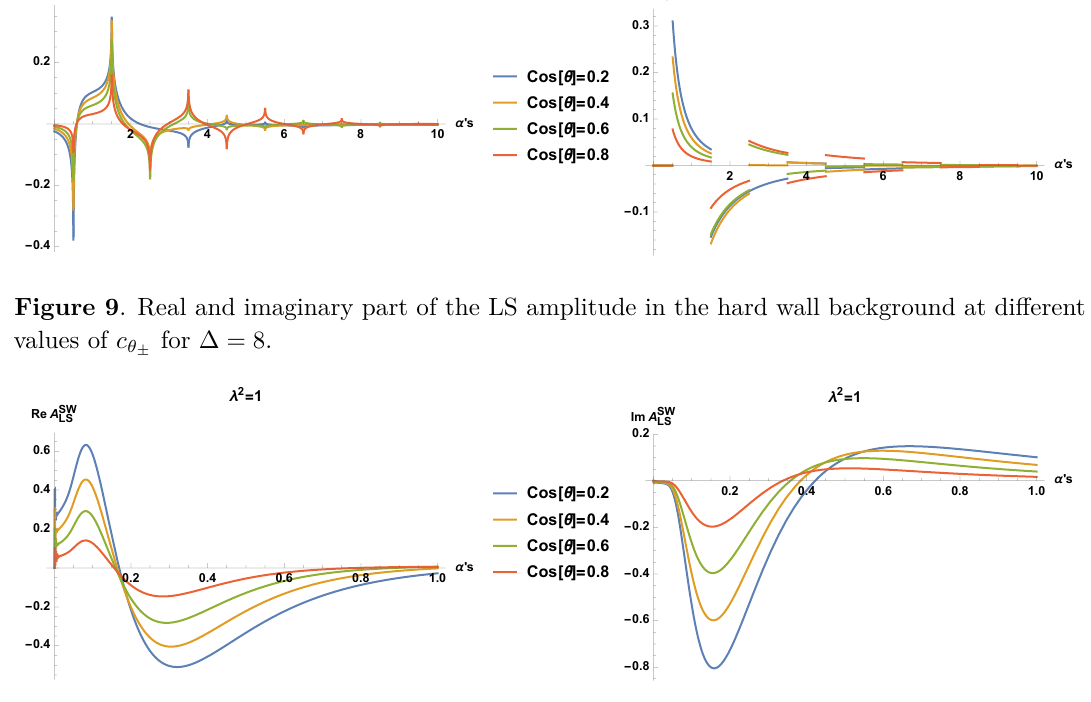
Figure 10 . Real and imaginary parts of the LS amplitude at different values of cosθ in the soft wall